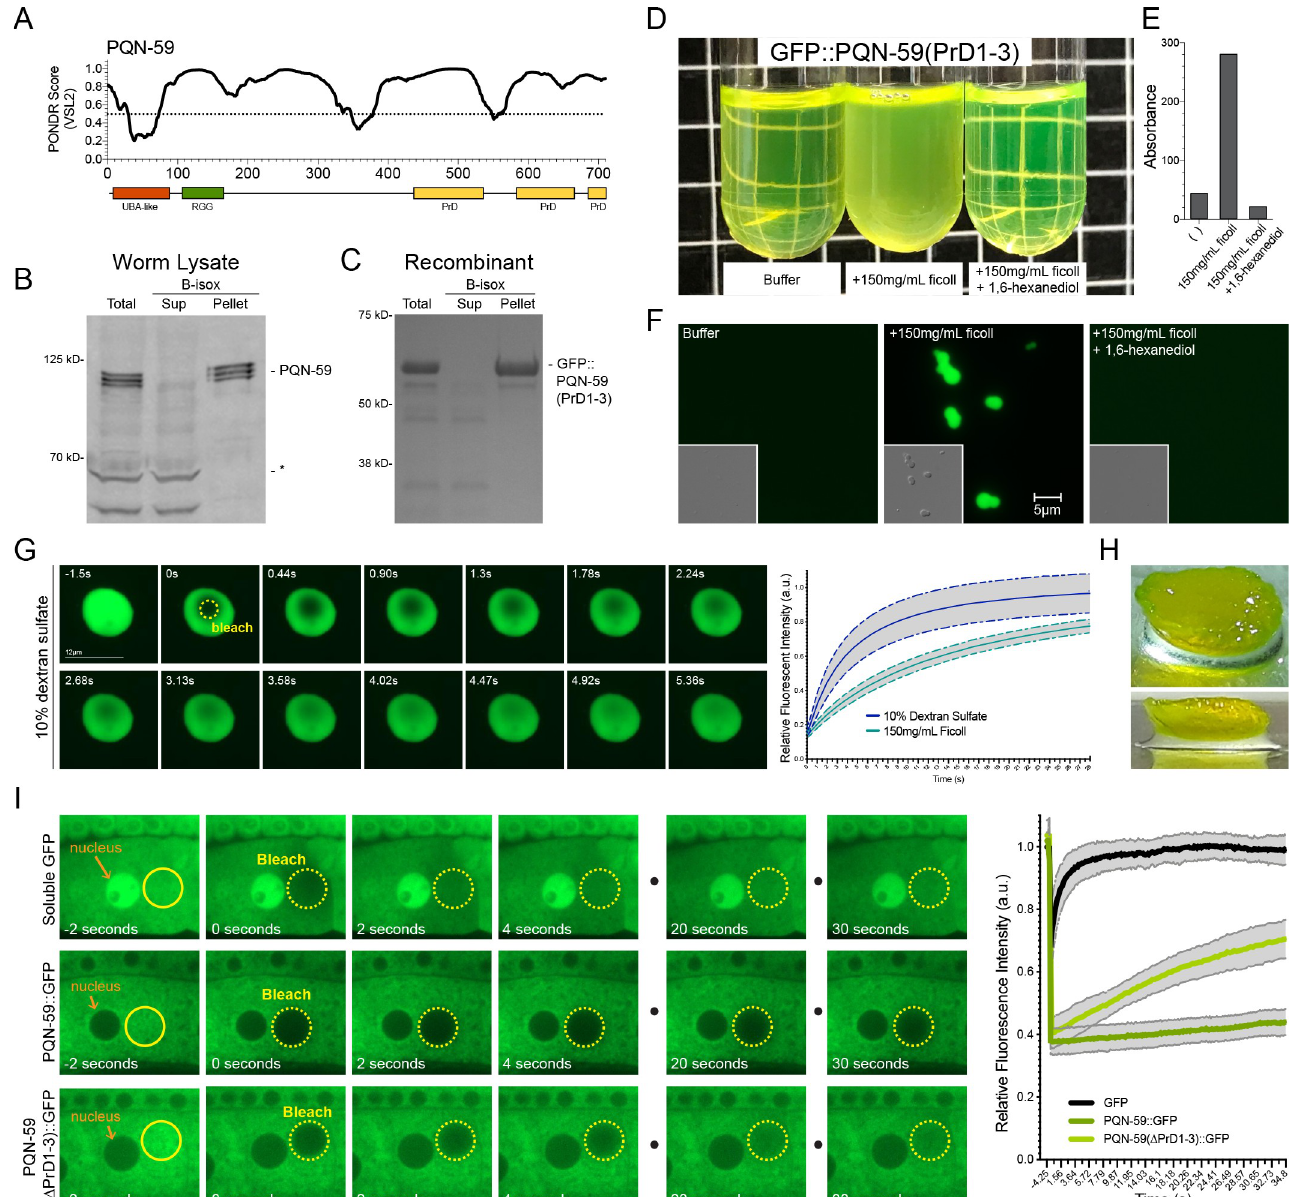
Fig 4. The “prion-like” domains of PQN-59 exhibit unique biophysical properties in vitro and in vivo . (A) A majority of the PQN-59 protein is predicted to be unfolded using the Predictors of Natural Disordered Regions (PONDR VSL2) algorithm [75]. (B and C) Endogenous, full-length PQN-59 in whole worm lysates and a GFP-tagged, C-terminal fragment of PQN-59 containing the three “prion-like” domains (PrDs) can be differentially co-precipitated with biotinylated-isoxazole (b-isox). (D-F) Solutions of purified GFP-PQN-59(PrD1-3) exhibit properties of LLPS when crowding reagents are added. Phase separation of GFP-PQN-59(PrD1-3) and increase absorbance phase separated samples are reversed upon addition of the aliphatic alcohol 1,6-hexandiol. (G) Phase separated droplets of GFP-PQN-59(PrD1-3) rapidly recover when photobleached. Graph depicts the rate of fluorescence recovery for GFP-PQN-59(PrD1- 3) droplets that were formed in either dextran sulfate or ficoll concentrating agents. Graphs depict the average recovery rate of the GFP-PQN-59(PrD1-3) droplets in indicated concentrating agent (n = or greater than 10). Grey regions indicate standard error of measurement (SEM). (H) Prolonged concentration of GFP-PQN-59(PrD1-3) droplets results in the formation of a GFP-PQN-59(PrD1-3) hydrogel-like material. (I) In vivo , full-length PQN-59::GFP exhibits slower diffusion rates that soluble GFP or GFP-PQN-59 fusion proteins lacking the three prion domains. These FRAP experiments were performed in developing oocytes. Graph indicates the recovery rates for the three proteins. PQN-59::GFP also exhibited slow diffusion rates in hypodermal cells (S3 Fig). Quantification of the average recovery rates for each GFP protein depicted in I. Grey regions indicate that standard error of measurements (SEM) for 10–15 photobleaching events in separate